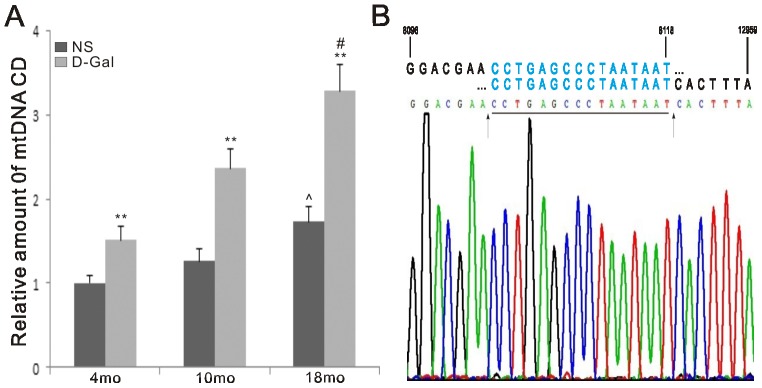
mtDNA common deletion in the auditory cortex and schematic diagram.A. Accumulation of mtDNA common deletion was measured using quantitative PCR. The levels of the mtDNA common deletion were significantly increased in the D-Gal groups compared to the corresponding NS groups. A significant difference was also found between the 4- and 18-month-old NS or D-Gal group. **Significantly different from the NS groups (P<0.01). ∧Significantly different from the 4-month-old NS group (P<0.01). # Significantly different from the 4-month-old D-Gal group (P<0.01). Data were expressed as the mean ± SEM. (n = 6 per subgroup). B. Schematic diagram and sequences of the 4834 bp mtDNA deletion (nt 8103 – nt 12936 or nt 8119 – nt 12952). Bold black letters indicate the nucleotide sequences flanking the breakpoints of the deleted mtDNA, and the bold blue letters indicate the direct repeats. Sequences of the PCR products are shown below the in schematic diagram. The arrowheads indicate the potential breakpoints.